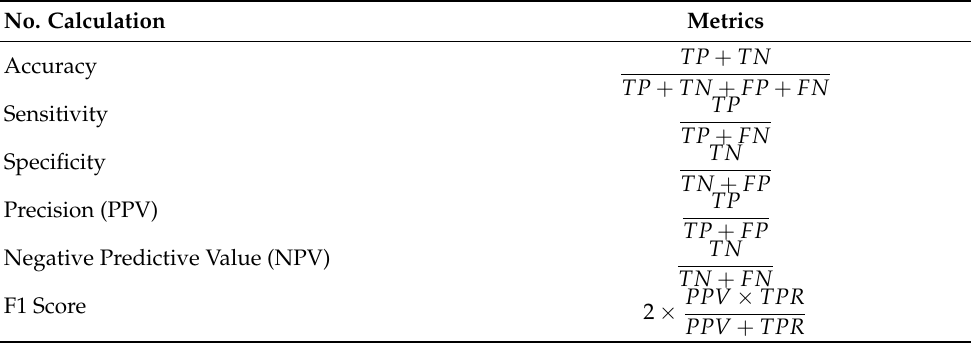
Table 3. Performance metrics used in